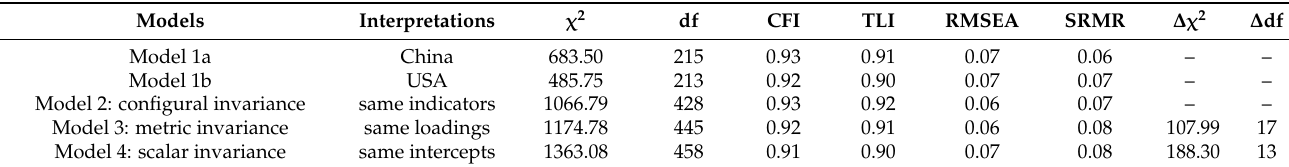
Table 2. Tests on the measurement equivalence between Chinese and US participants.